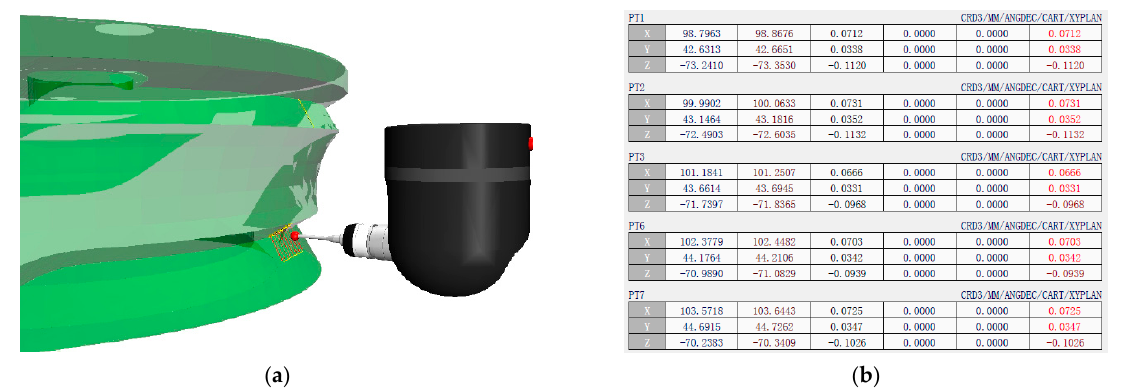
Figure 10. Results of CMM. ( a ) Measuring position; ( b ) Measuring data.